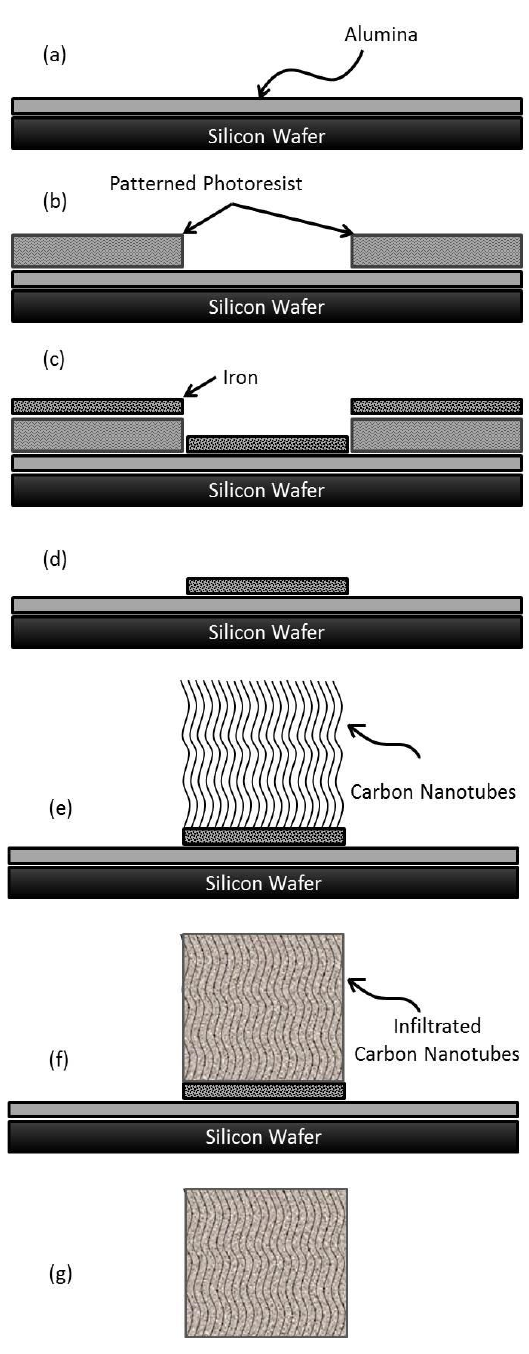
Figure 4. (a) Alumina is deposited (30nm) via PECVD to prevent iron di ff usion into the silicon. (b) A positive photoresist is spun onto the wafer and lithographically patterned. (c) Iron is deposited by thermal evaporation to a thickness of 4nm. (d) The remaining pho- toresist is removed along with the iron on top of it. (e) Carbon nan- otubes grow on the patterned iron via chemical vapor deposition. (f) The nanotube forest is filled with amorphous carbon. (g) The final structure is then removed from the substrate for